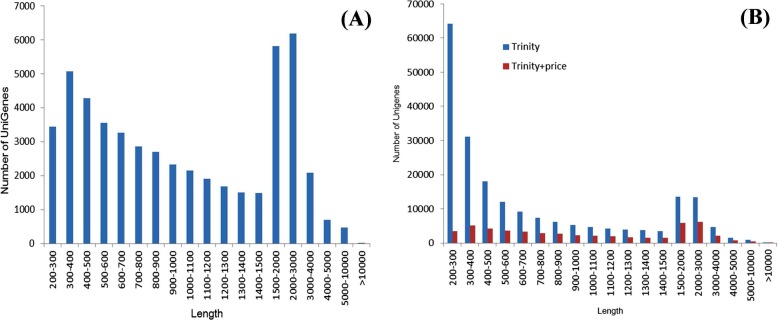
The length distribution (bp) of ‘Hangbaishao’ unigenes.
(A) The length distribution of ‘Hangbaishao’ unigenes assembled by “Trinity+PRICE”. (B) Comparison of the length distribution of unigenes assembled by “Trinity” and “Trinity+PRICE”.